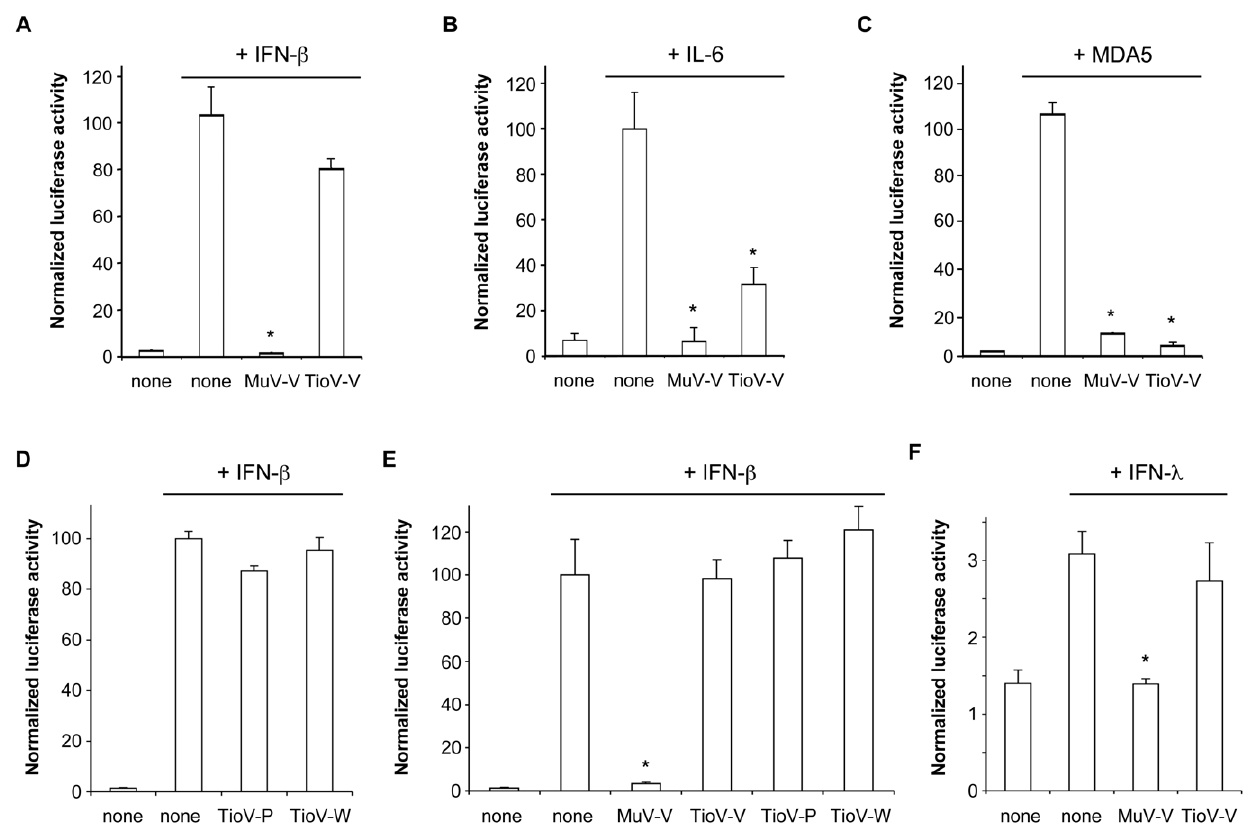
Figure 3. TioV-V inhibits IFN- b promoter activation by MDA5 and IL-6 signaling, but not IFN- a / b signaling. ( A ) HEK-293T cells were co- transfected with reporter plasmid pISRE-Luc (300 ng/well), pRL-CMV reference plasmid (30 ng/well), and pCI-neo-3xFLAG expression vectors encoding for 3xFLAG alone or fused to MuV-V or TioV-V (300 ng/well). After 24 h, recombinant IFN- b was added at 200 IU/ml. After an additional 24 h, relative luciferase activity was determined. ( B ) HEK-293T cells were co-transfected with reporter plasmid pSTAT3-Luc (300 ng/well), pRL-CMV (30 ng/well), and expression vectors encoding 3xFLAG-tagged MuV-V or TioV-V (300 ng/well). At 24 h post-transfection, recombinant IL-6 was added at 10 ng/ml. After an additional 24 h, relative luciferase activity was determined. ( C ) HEK-293T cells were co-transfected with IFN- b -pGL3 reporter plasmid (300 ng/well), pRL-CMV (30 ng/well), expression vectors encoding 3xFLAG-tagged MDA5 (300 ng/well) and MuV-V or TioV-V (300 ng/well). After 48 h, relative luciferase activity was determined. ( D ) Experiment was performed as in (A), but cells were co-transfected with expression vectors encoding 3xFLAG-tagged TioV-P or TioV-W. ( E ) Experiment was performed as in (A), but cells were co-transfected with pCI-neo expression vector, either empty or encoding untagged MuV-V, TioV-V, TioV-P or TioV-W. ( F ) Experiment was performed as in (A), but cells were stimulated